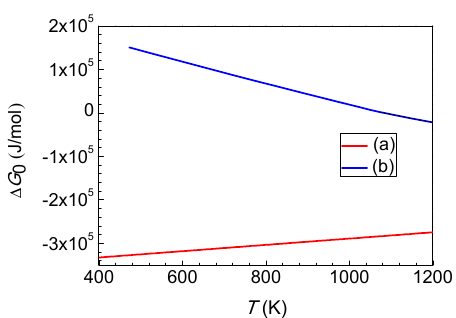
Figure 4. Dependence curve of the standard Gibbs free energy change ( ∆ G 0 ) on temperature ( T ) for the chemical reaction. ( a ) Positive slope ( ∆ S 0 < 0); ( b ) negative slope ( ∆ S 0 > 0).